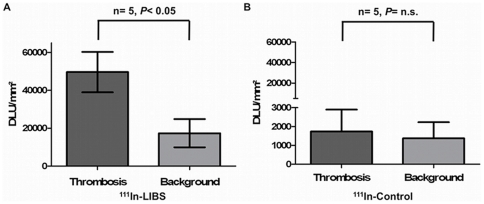
Evaluation of ex vivo autoradiographic
results.Autoradiographic results after incubation of the injured and non-injured
carotid artery with 111In-LIBS or 111In-Control.
Compared to the contralateral non-injured side, indicated as
“Background“, incubation with 111In-LIBS results
in a significant increase in the absolute autoradiographic ligand uptake
(DLU/mm3) of the injured carotid artery (A;
n = 5; P<0.05). Changes in
uptake were not significant after incubation with
111In-control (B; n = 5,
p = n.s.). Ex vivo results
indicate a specificity of 111In-LIBS for targeting activated
platelets.